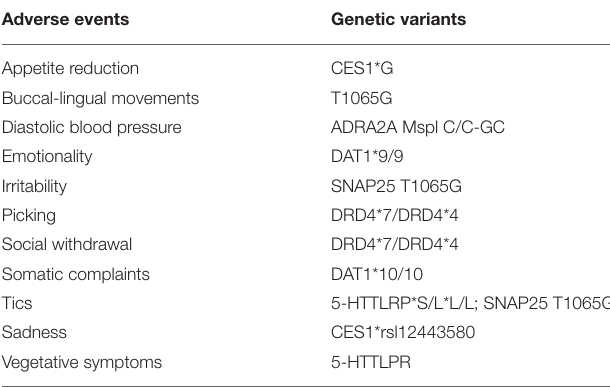
TABLE 4 | Associations between adverse events to ADHD medication and genetic variants (Joensen et al.,